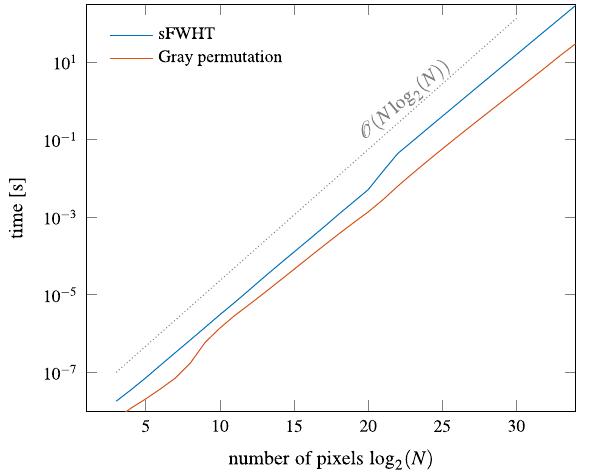
Figure 1. Scaling for scaled fast Walsh–Hadamard transform (sFWHT) and in-place Gray permutation with QPIXL++